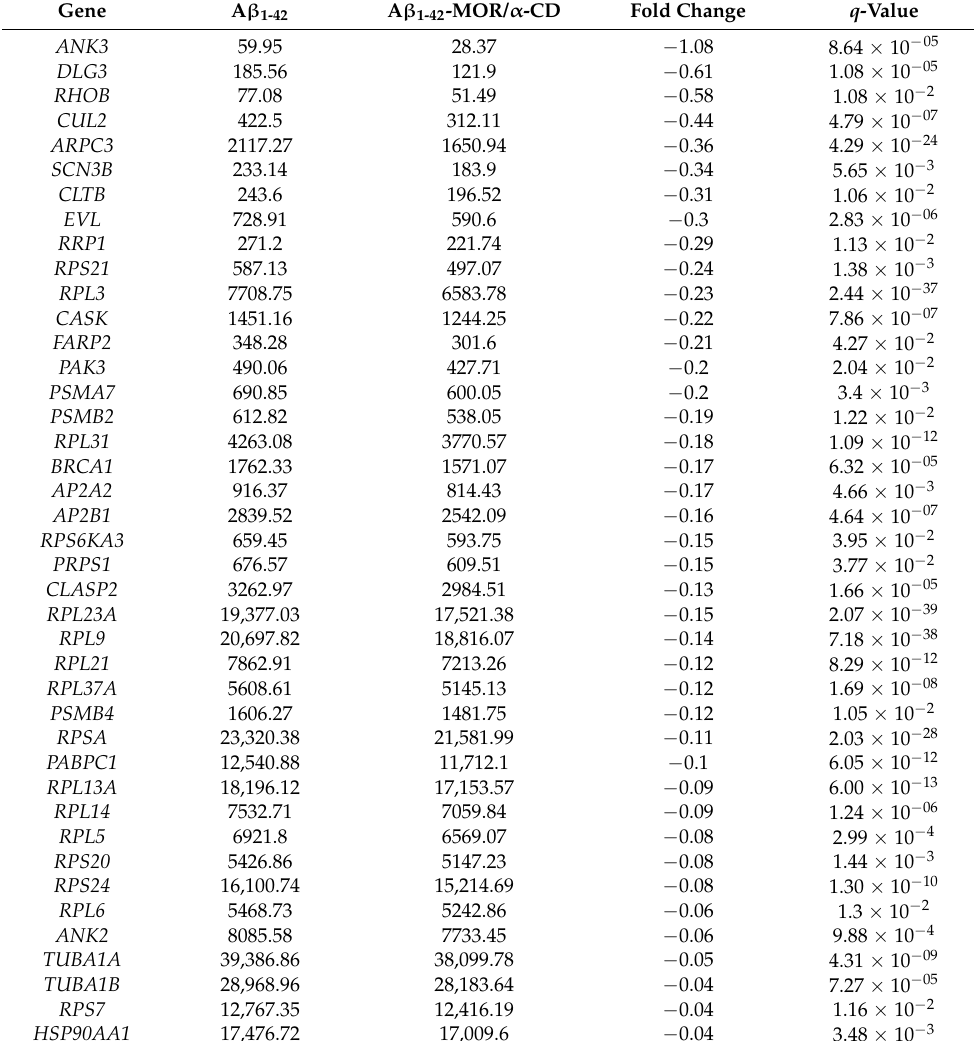
Table 3. Differentially expressed genes exclusively enriched in “Cellular Repair”